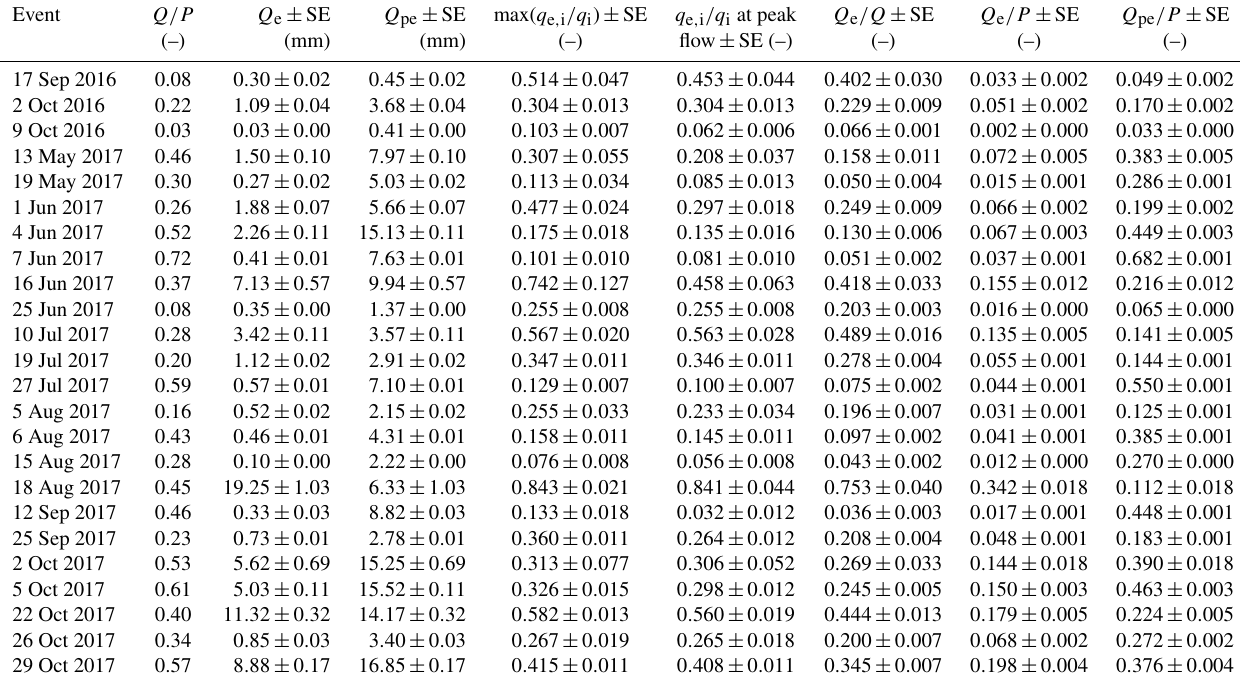
Table 2. Results of hydrograph separations based on δ 2 H (results for δ 18 O are provided in Table S1). Columns are the runoff coefficient ( Q/P ), event and pre-event discharge as whole-storm totals ( Q e and Q pe ), the maximum instantaneous event-water fraction q e , i /q i and its value at peak flow, the event-water fractions ( Q e /Q ), as well as the event and pre-event runoff coefficients ( Q e /P and Q pe /P ).